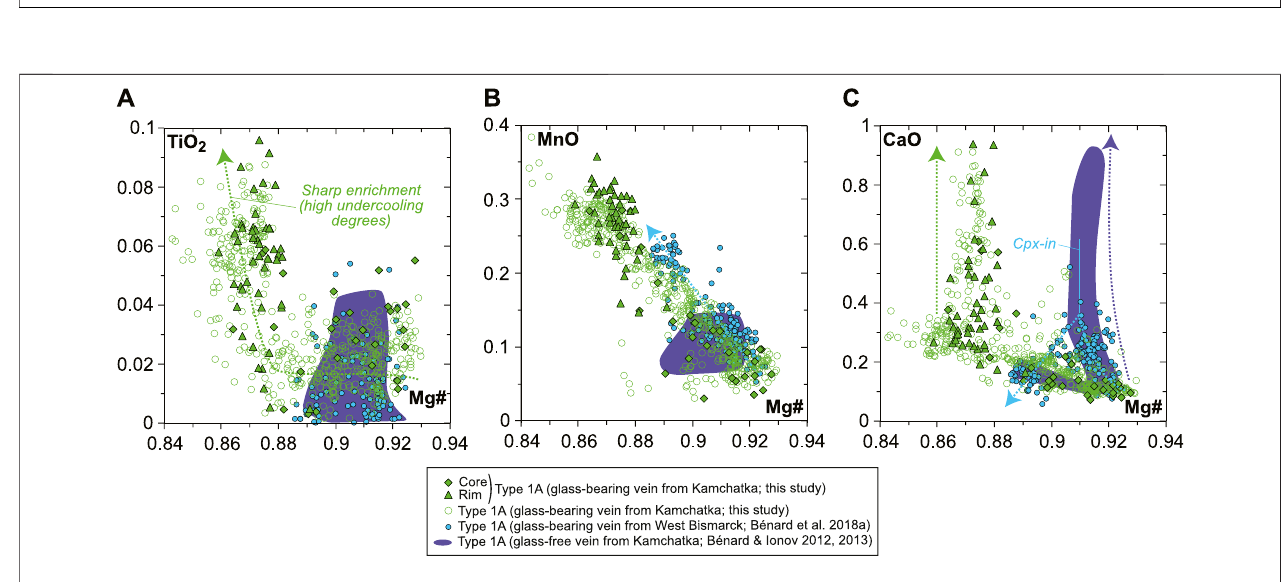
FIGURE 4 | Orthopyroxene major element compositions (in wt% for oxides) for the new Kamchatka vein in this study.